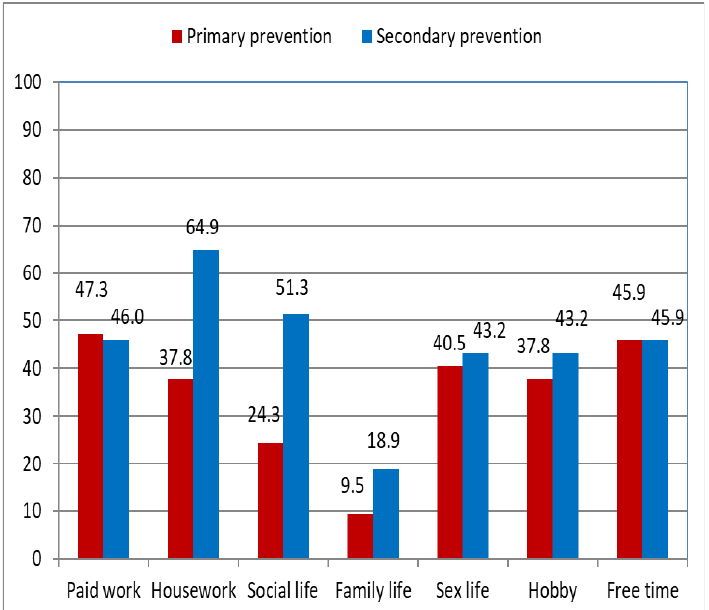
Figure 3. Quality of life measured using the Nottingham Health Profile questionnaire, according to type of prevention.